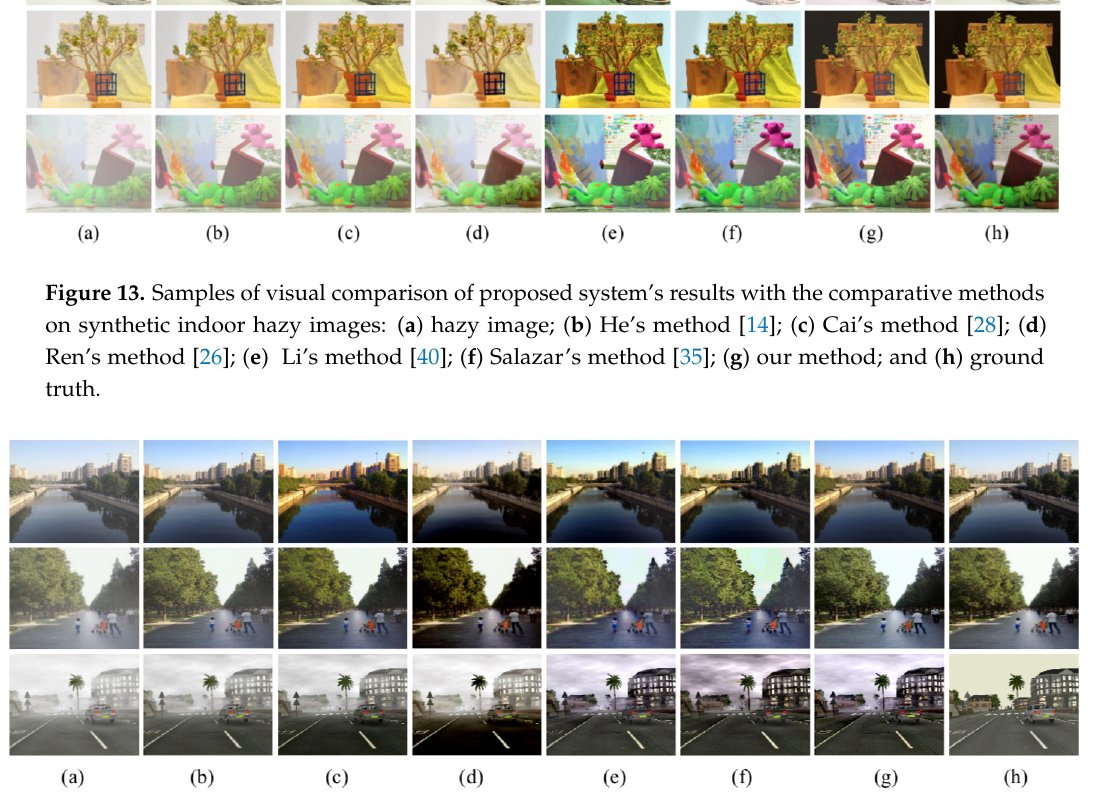
Figure 14. Samples of visual comparison of proposed system’s results with the comparative methods on synthetic outdoor hazy images: ( a ) hazy image; ( b ) He’s method [14]; ( c ) Cai’s method [28]; ( d ) Ren’s method [26]; ( e ) Li’s method [40]; ( f ) Salazar’s method [35]; ( g ) our method; and ( h ) ground